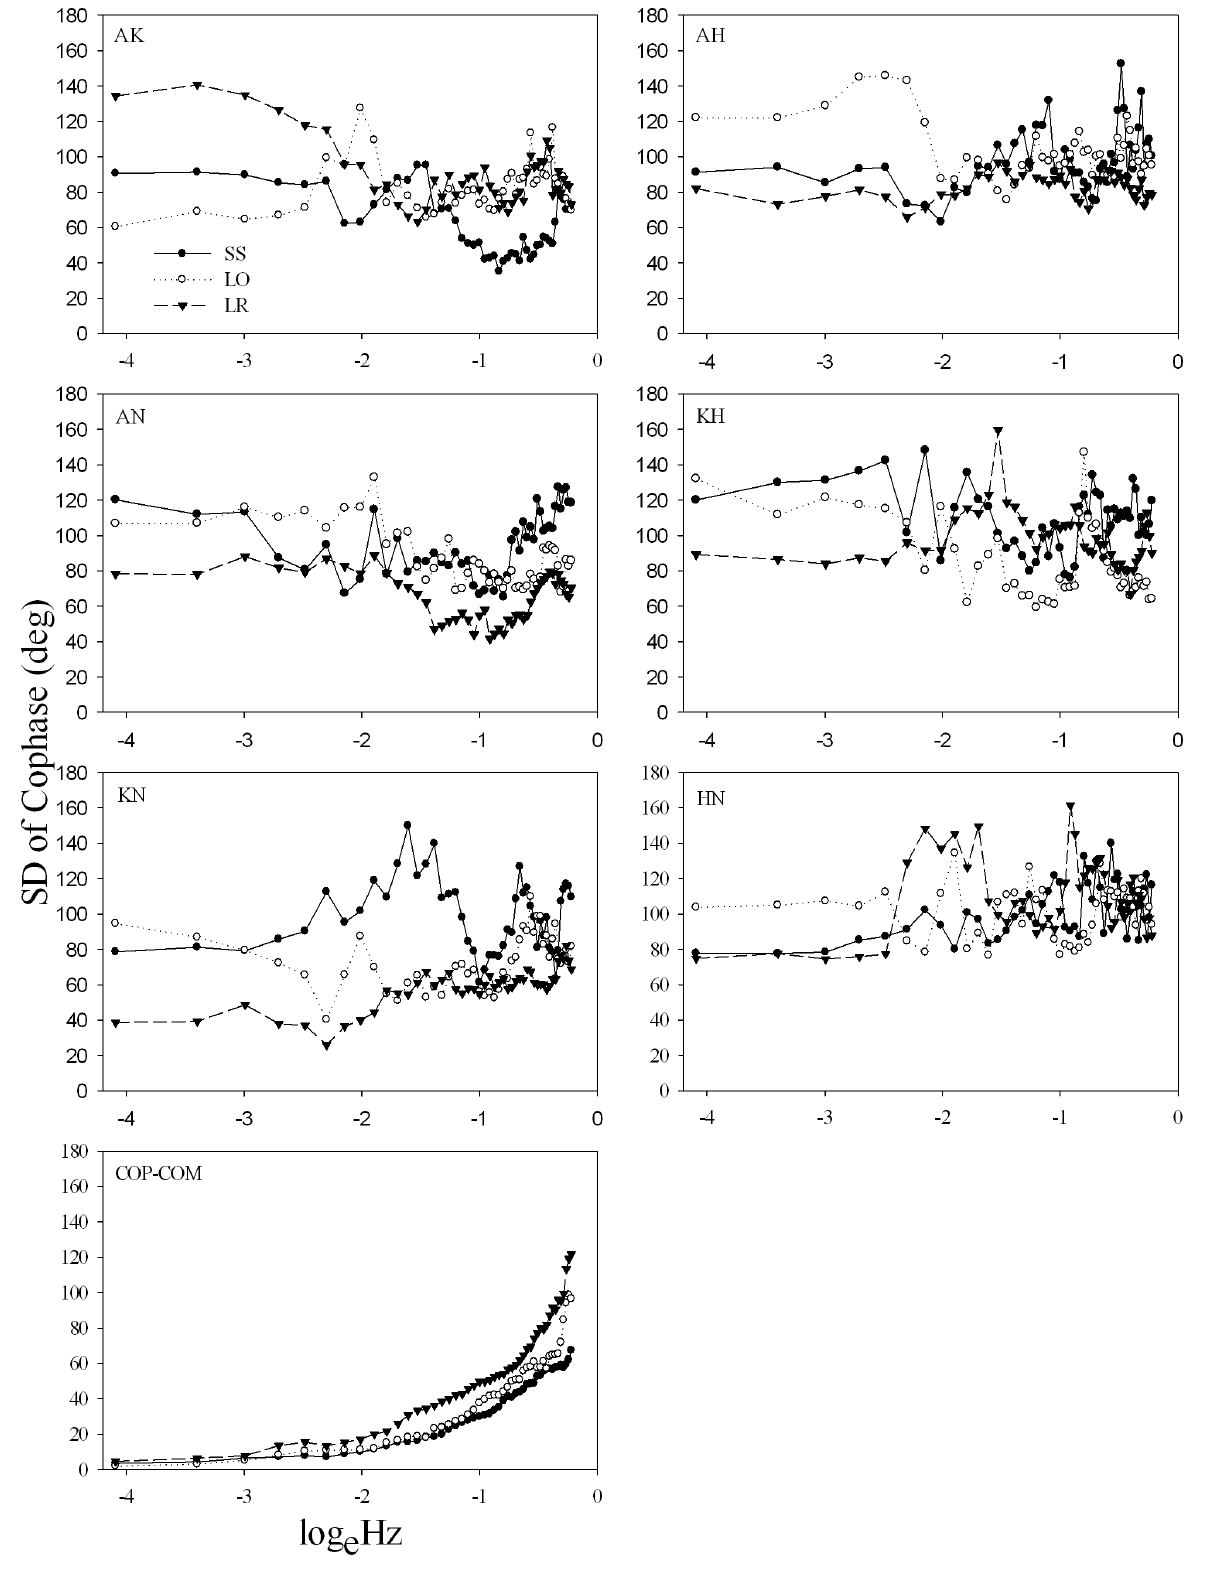
Figure 5. Cophase SD (group mean) of all pairs of joint synergies and COP-COM coupling at different standing conditions. Anatomical abbreviations are as in Fig. 2.